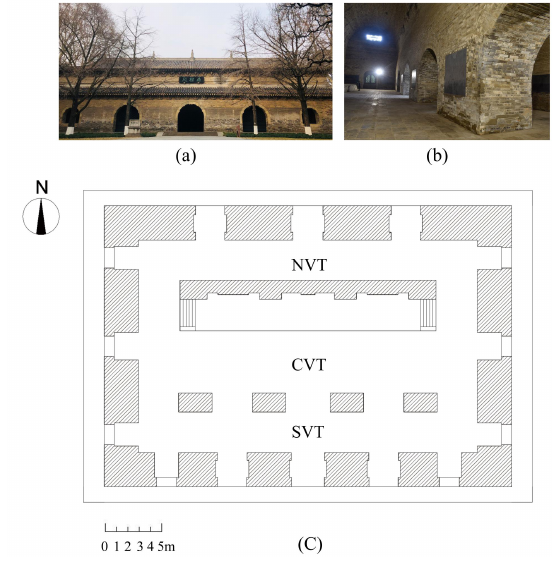
Figure 1. The Beamless Hall at Linggu Temple: (a) exterior view; (b) interior view; (c) floor plan.